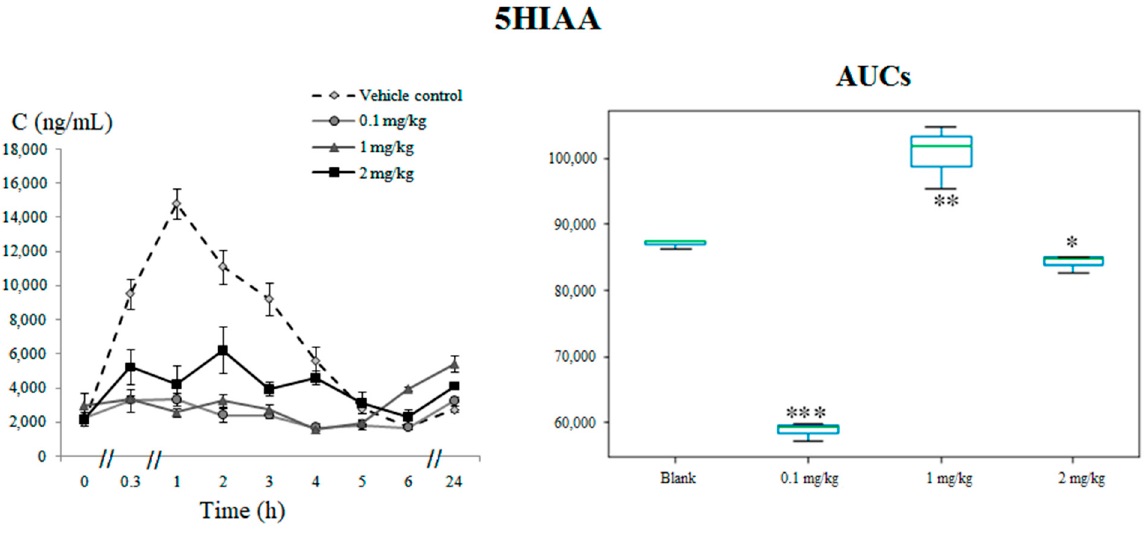
Figure 2. Metabolites related with the serotonergic system–serotonin pathway, including: ( A ) time-concentration profile and boxplots of the AUC for tryptophan and ( B ) time-concentration profile and boxplots of the AUC for 5-Hydroxylindole acetic acid. Statistically significant differences in the AUCs between the vehicle control versus the test groups are marked with asterisks as * p < 0.05, ** p < 0.01 and *** p < 0.001.